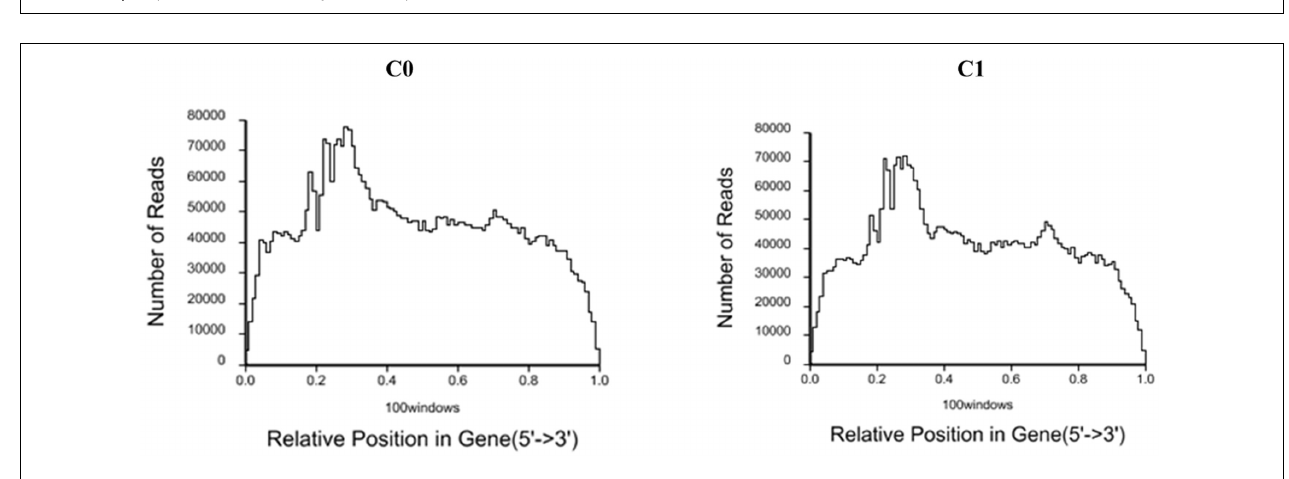
FIGURE 2 | Sequence saturation analysis of samples C0 and C1.